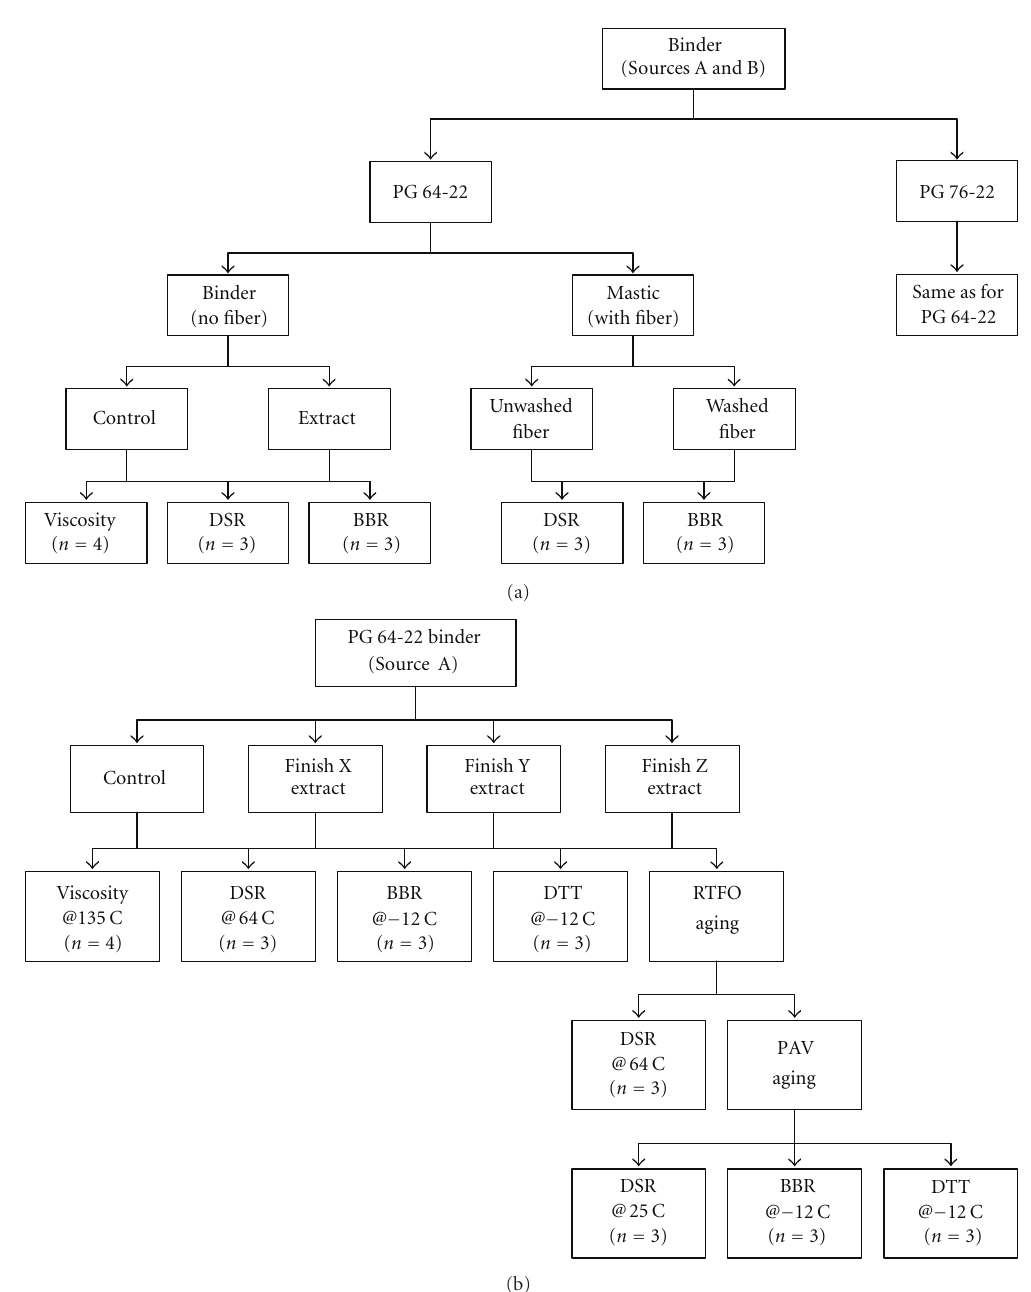
Figure 1: Experimental designs for (a) Phase 1 and (b) Phase